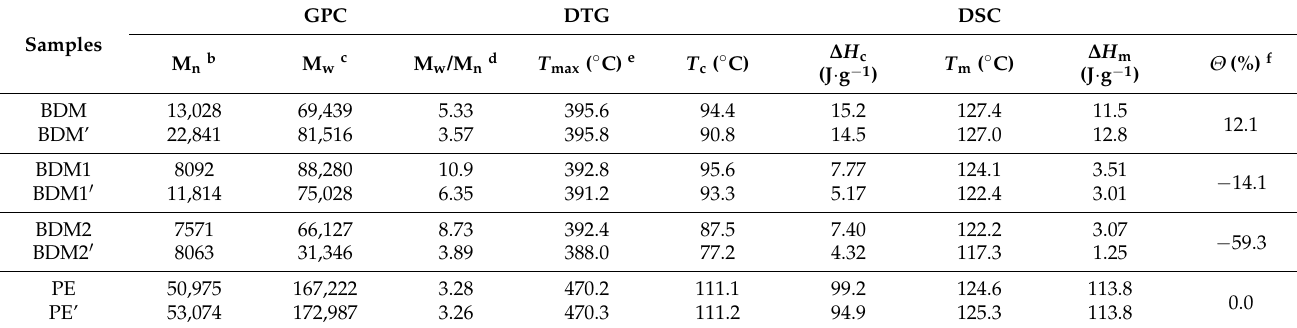
Table 2. Important data from GPC, DSC, and TG determination a